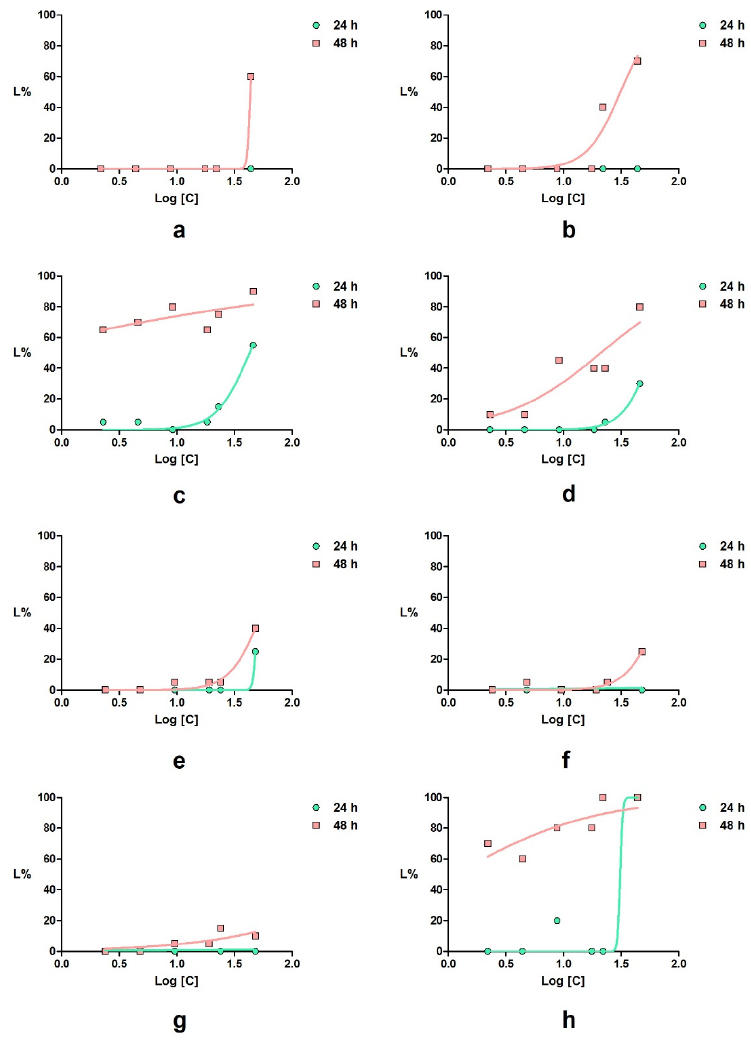
Figure 4. Daphnia magna lethality curves for the tested compounds: ( a ) 5 ; ( b ) 6 ; ( c ) 7a ; ( d ) 7b ; ( e ) 8a ; ( f ) 8b ; ( g ) L -valine (control 1); ( h ) 3 (control 2).